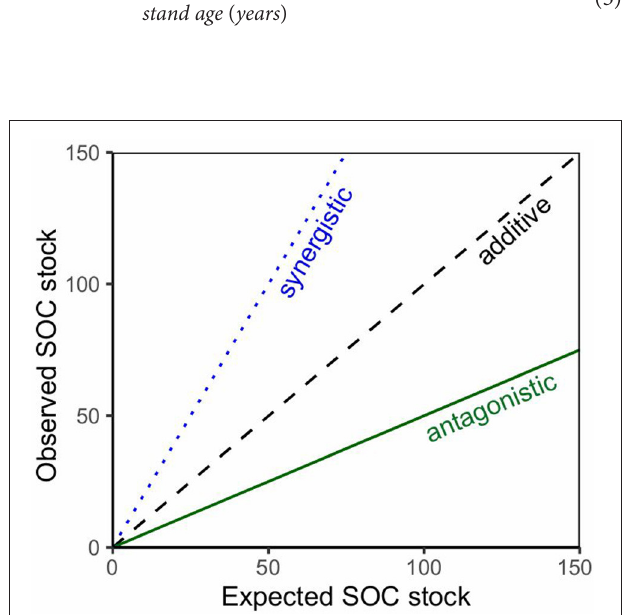
FIGURE 2 | Mixing effects derived from the relation of expected SOC stocks of mixed forest stands (based on calculated stocks using the corresponding monocultures) and observed SOC stocks for the mixed